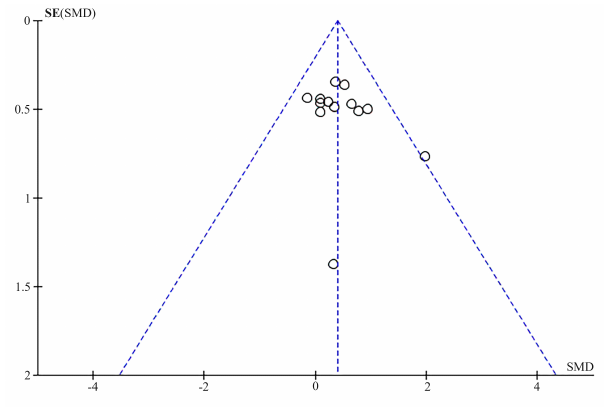
Fig. 4. Plot of publication